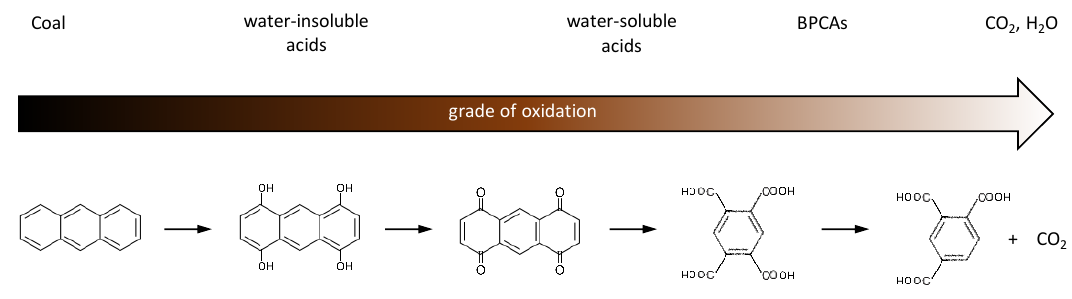
Figure 3. Oxidation of coal and anthracene depending on oxygen amount [23].